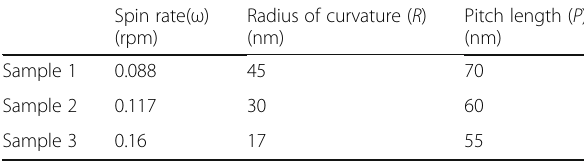
Table 1 Radius of curvature and pitch length of the three samples Spin rate( ω ) Radius of curvature ( R ) (rpm) (nm)